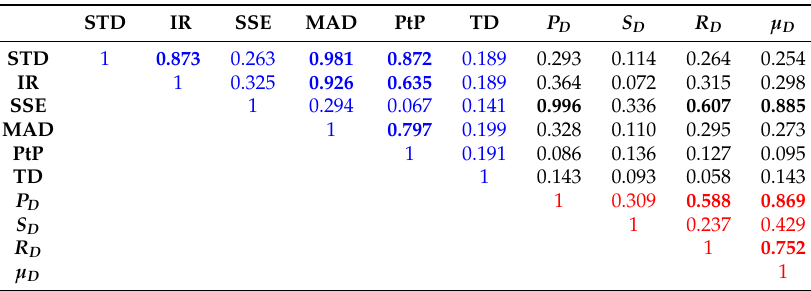
Table 1. Correlation check of available